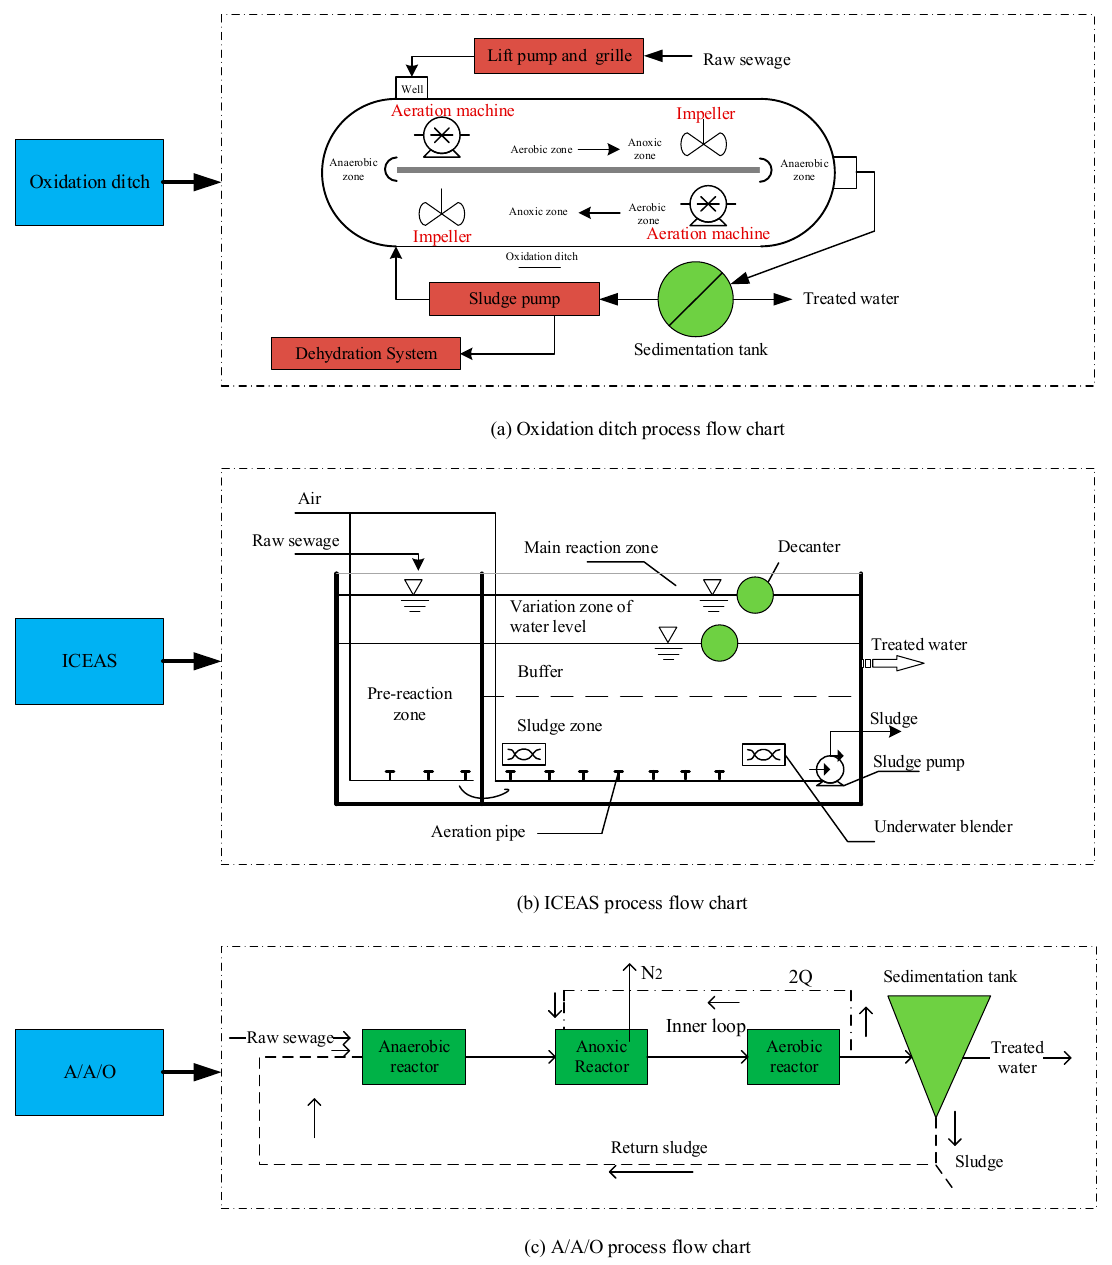
Figure 3. Three types of sewage treatment process flow charts.